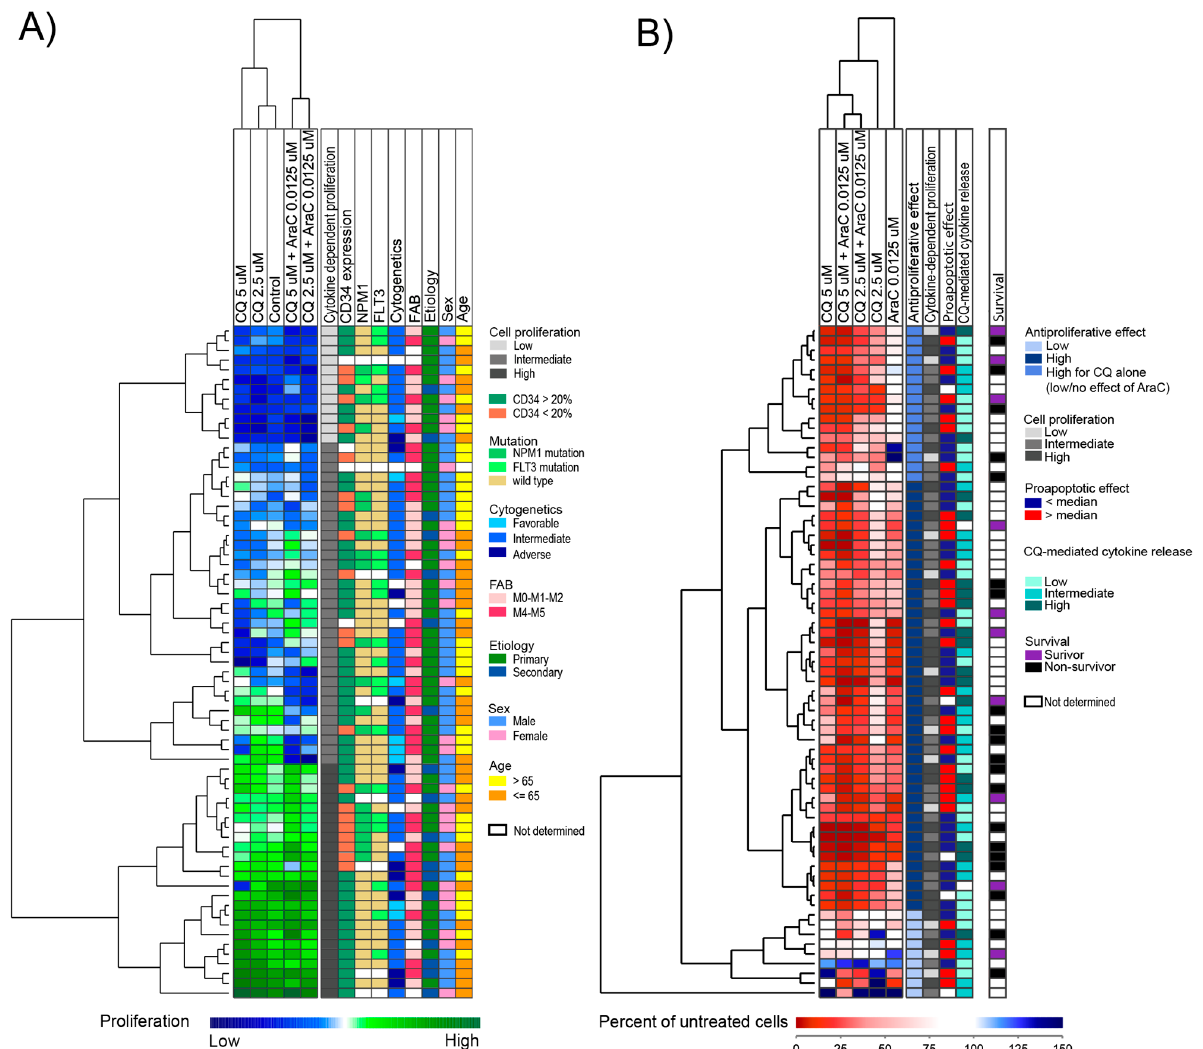
Figure 4. An unsupervised hierarchical cluster analysis based on the effect of chloroquine and cytarabine/AraC on AML cell proliferation. AML cells from 81 consecutive patients were cultured for seven days with chloroquine (CQ 2.5 and 5 µM), AraC (0.0125 µM), chloroquine in combination with AraC or medium alone (control). Proliferation was measured using a 3H-thymidine incorporation assay. Detectable proliferation was defined as >1000 cpm, and results are presented for the 69 patients with detectable proliferation in untreated cultures. ( A ) The figure illustrates the cytokine-dependent AML cell proliferation for the untreated controls and drug-treated cultures (chloroquine or a combination of drugs) after results were normalized to the corresponding median for each group. The cluster could be divided into three main subsets based on the degree of proliferation as illustrated in the first column to the right: (i) low proliferation (upper cluster, light gray), (ii) intermediate proliferation (middle, gray), and (iii) high proliferation (lower cluster, dark gray). The figure also shows the distribution of biological and clinical characteristics for each individual patient (columns on the right part of the figure). ( B ) The figure shows the relative AML cell proliferation (i.e., percent proliferation compared to untreated controls) for the 69 AML patients after treatment with chloroquine and AraC. As shown, the majority of patients had a strong inhibitory effect of chloroquine, AraC or both drugs (two top subclusters, shown as blue and dark blue in the column to the right). A small subcluster of nine patients (bottom subcluster, shown as light blue in the column to the right) had mainly little or no effect of these treatments at the tested concentrations. Shown in different columns to the right of the figure are different patient subsets based on clustering of cytokine-dependent proliferation (patient classification as indicated in Figure 4A), proapoptotic effects (classified based on Figure 5, see Section 3.8), chloroquine-mediated cytokine release (based on Figure 6, see Section 3.9), and survival after completed intensive treatment. Survival is presented only for patients who completed the planned intensive and consolidation treatment, and all patients classified as survivors were observed for at least three years after treatment.